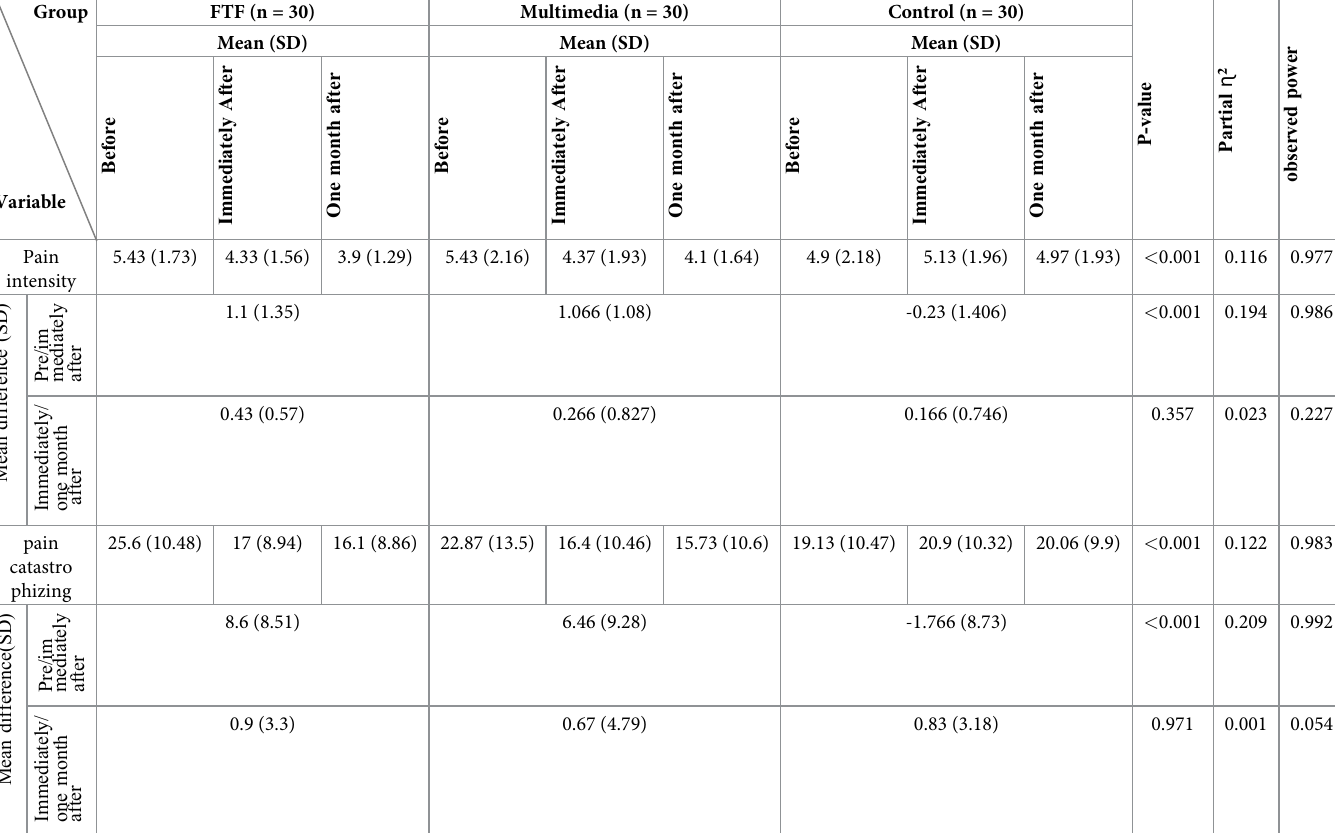
Table 2. Comparison of the study variables in the three groups